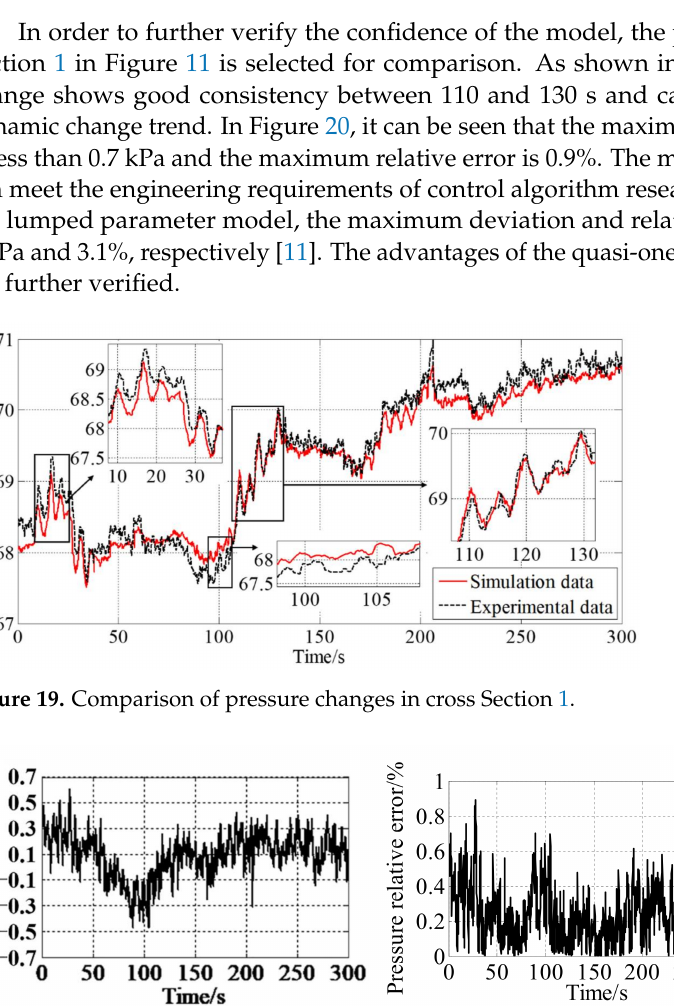
Figure 18. Mass flow error. ( a ) Flow deviation; ( b ) Flow relative error.